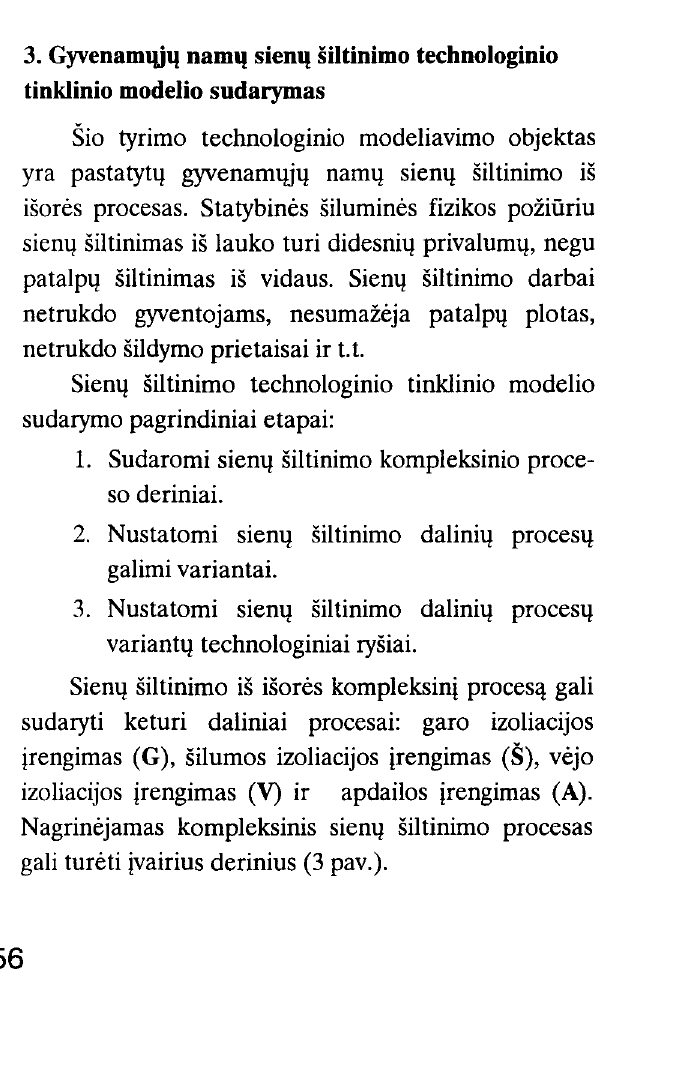
Fig 2. The technological system of the building